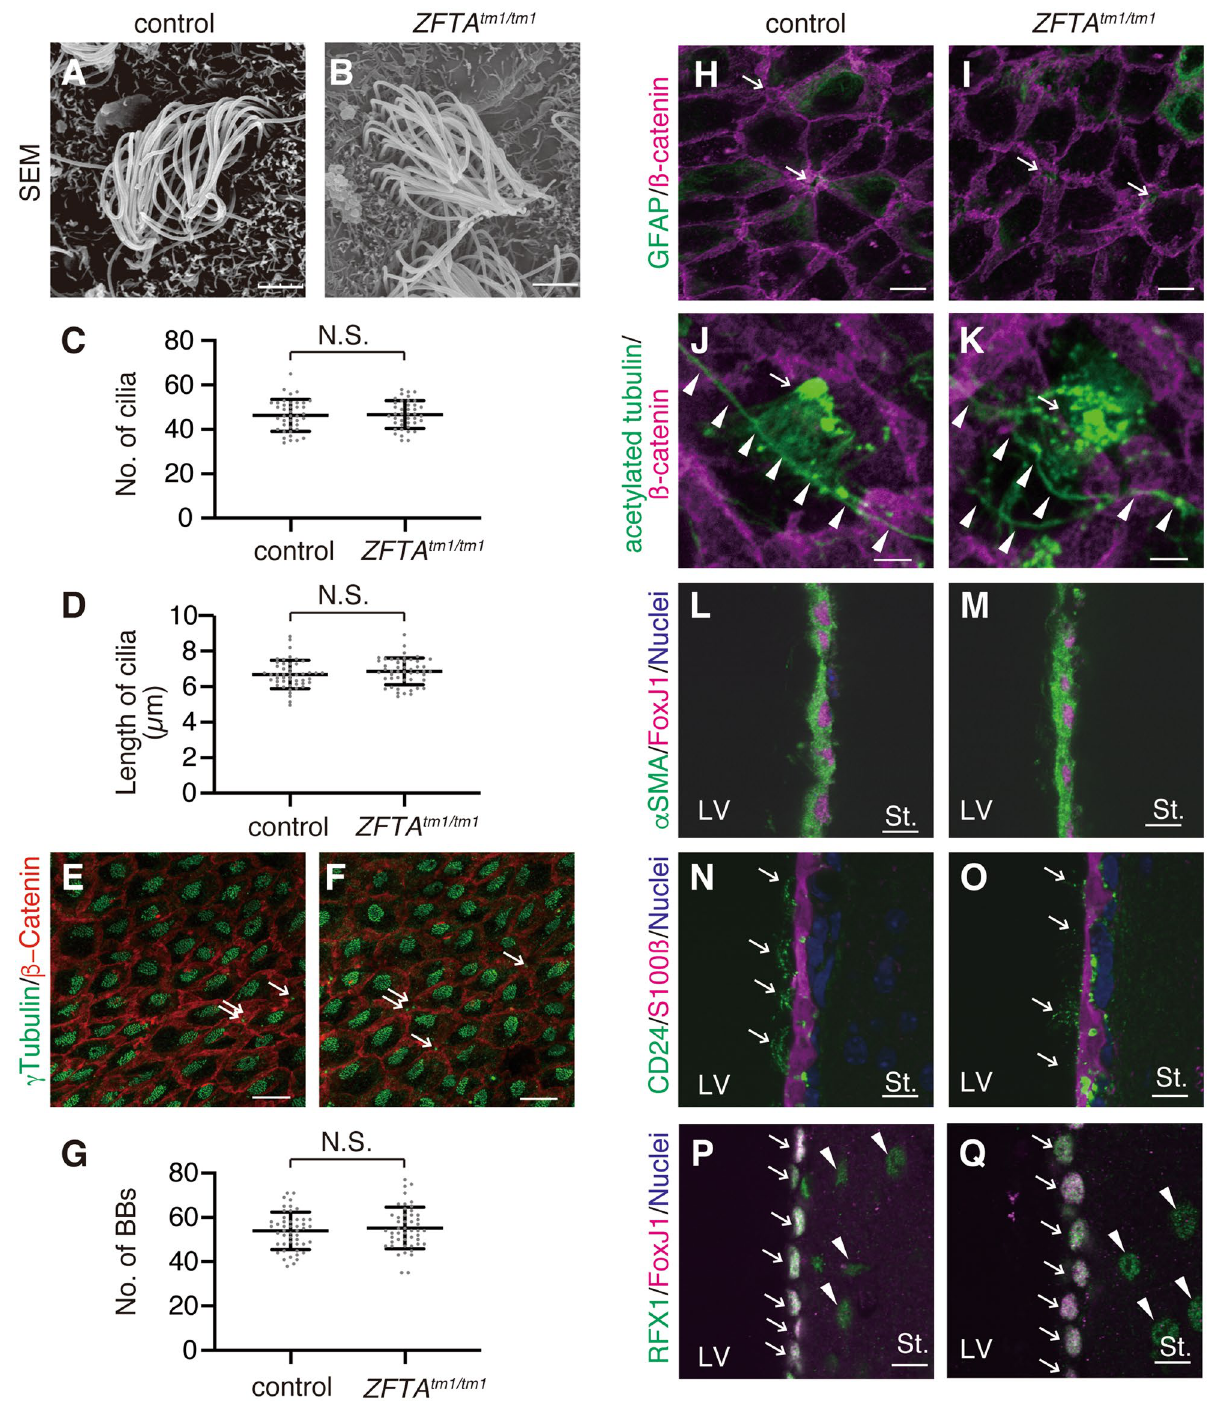
Figure 4. Normal development of E1 cells in Zfta tm1/tm1 mice. (A–D) Wholemount preparations of the lateral walls of the LV were observed by SEM in WT ( A ) and Zfta tm/tm ( B ) mice. Bar = 2.5 µm. The number ( C ; n = 40 E1 cells from 4 control mice, n = 41 E1 cells from 4 ZFTA tm/tm mice; p = 0.80) and length ( D ; n = 48 cilia from 4 control mice, n = 48 cilia from 4 Zfta tm/tm mice; p = 0.28) of E1 cells’ motile cilia were quantified and plotted. Data shown are the mean ± SEM. Each point on the graph is the number of cilia in an individual E1 cell ( C ) and the length of an individual cilium ( D ). N.S., not significant. ( E – K ) Wholemount preparations of the lateral walls of LV at P30–35 were stained with antibodies against γ-tubulin (green in E , F ), GFAP (green in H , I ), acetylated tubulin (green in J , K ) and β-catenin (red in E , F , magenta in E , F , H – K ) in the control ( E , H , J ) and Zfta tm/tm ( F , I , K ) mice. Bars = 10 µm ( H , I , L – Q ) and 40 µm ( I , K ). ( G ) The number of BBs was quantified in the WT (n = 48 E1 cells from 3 mice) and Zfta tm1/tm1 (n = 48 E1 cells from 3 mice, p = 0.50) E1 cells. Data shown are the mean ± SD. Each point on the graph is the number of BBs in an individual E cell. ( L – Q ) Coronal vibratome sections were stained with anti-αSMA (green in L , M ), anti-FoxJ1 (magenta in L , M , P , Q ), anti-CD24 antigen (green in N , O ), anti- S100β (magenta in N , O ) and anti-RFX1 (green in P , Q ) antibodies in the control ( L , N , P ) and ZFTA tm1/tm1 ( M , O , Q ) mice at P30–35. Bar = 10 µm. The white arrows in N and O indicate the CD24-immunoreactive motile cilia of E1 cells. The white arrows and arrowheads in P and Q indicate the RFX1/FoxJ1-double positive E1 cells and RFX1-positive parenchymal cells, respectively. LV, lateral ventricle; St.,